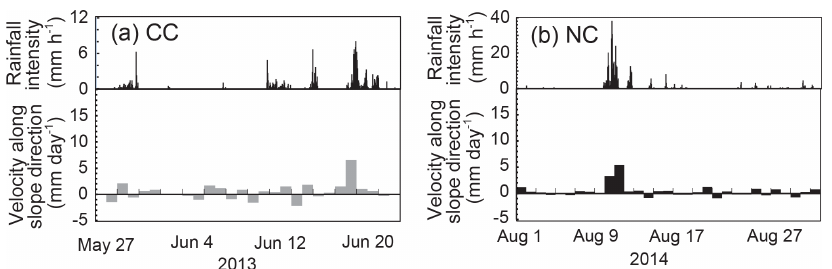
Figure 9. Velocity of ground surface sediment during rainfall seasons. (a) Velocity at site CC (CCR) in the period 27 May to 23 June 2013. (b) Velocity in site NC (NCR) in the period 1 to 31 August 2014. Periods in (a) and (b) are different, because we could not successfully obtain velocity of the ground surface sediment both in CC and NC during the same heavy rainfall event.